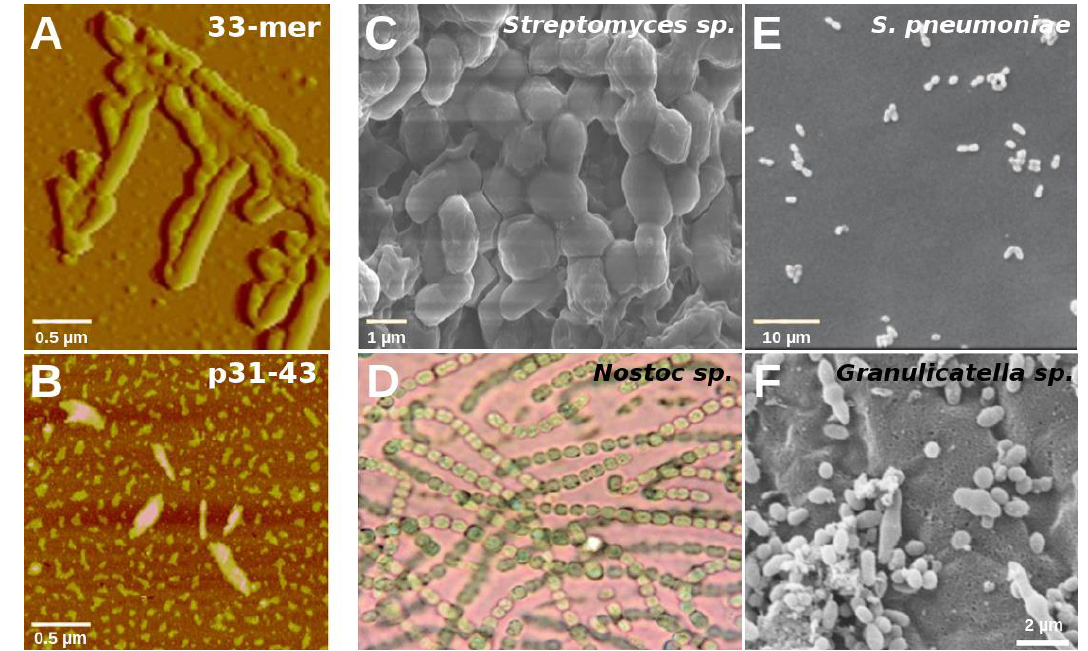
Figure 8. Morphology of host organisms associated with the 33-mer and p31-43 peptide BLASTp hits. Topology of the 33-mer (( A ), adapted with permission from Reference [18]) and p31-43 oligomers (( B ), adapted with permission from Reference [25]) alongside with the morphology of representative host organisms found in our work: Streptomyces sp. VN1 (( C ), adapted from Reference [90]), Nostoc sp. EA03 (( D ), adapted from Reference [91]), Staphylococcus pneumoniae TIGR4 (( E ), adapted from Reference [92]) and Granulicatella adiacens (( F ), adapted from Reference [93]). Images in panels ( C – F ) are under CC BY